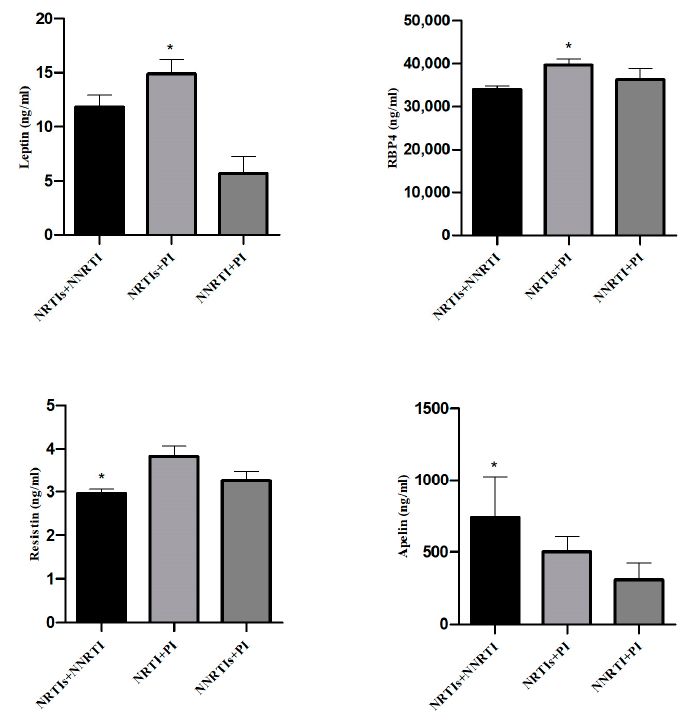
Figure 6. Adipokine concentrations in different ART schemes. ( A ) Circulating adipokine concentra- tions affected by the 2 NRTIs + PI scheme ( n = 91) at 48 weeks. ( B ) Circulating adipokine